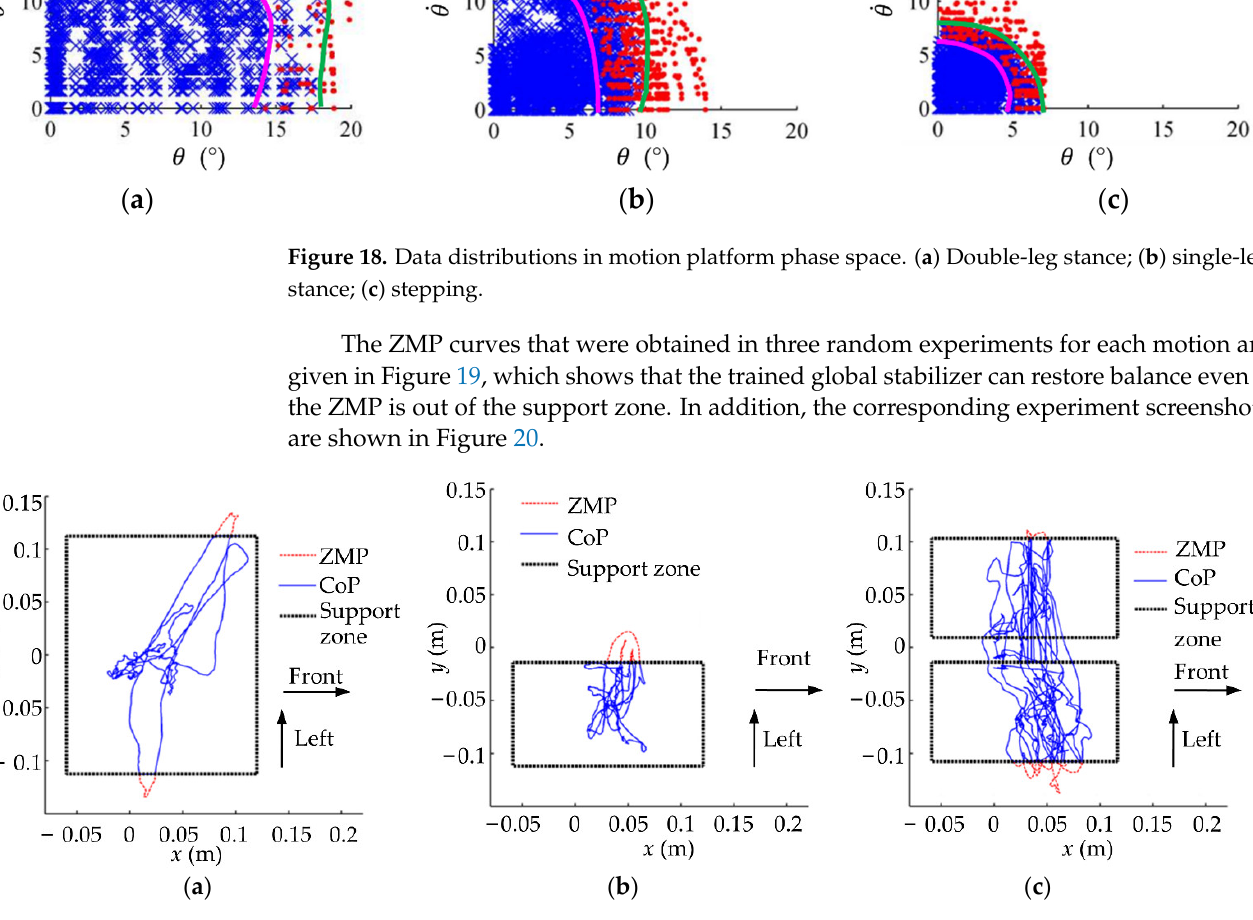
Figure 19. ZMP curves in three experiments. ( a ) Double-leg stance; ( b ) single-leg stance; ( c ) stepping.